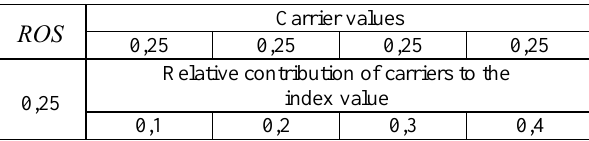
Table 2. The structure of market concentration depending on the formula used in calculation Relations between the sizes of attribute